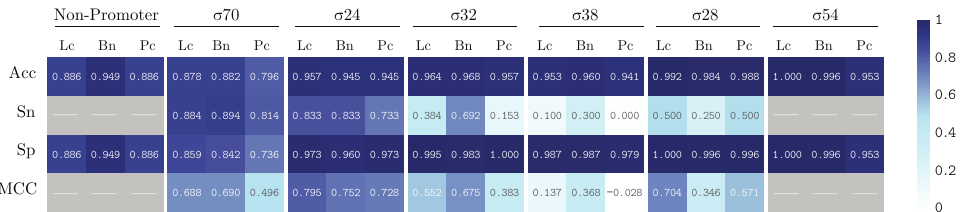
Figure 5. Performance over the training dataset for PromoterLCNN (Lc), pcPromoter-CNN (Pc) and iPromoter-BcNN (Bc), measuring accuracy (Acc), sensitivity (Sn), specificity (Sp) and Matthews correlation coefficient (MCC).